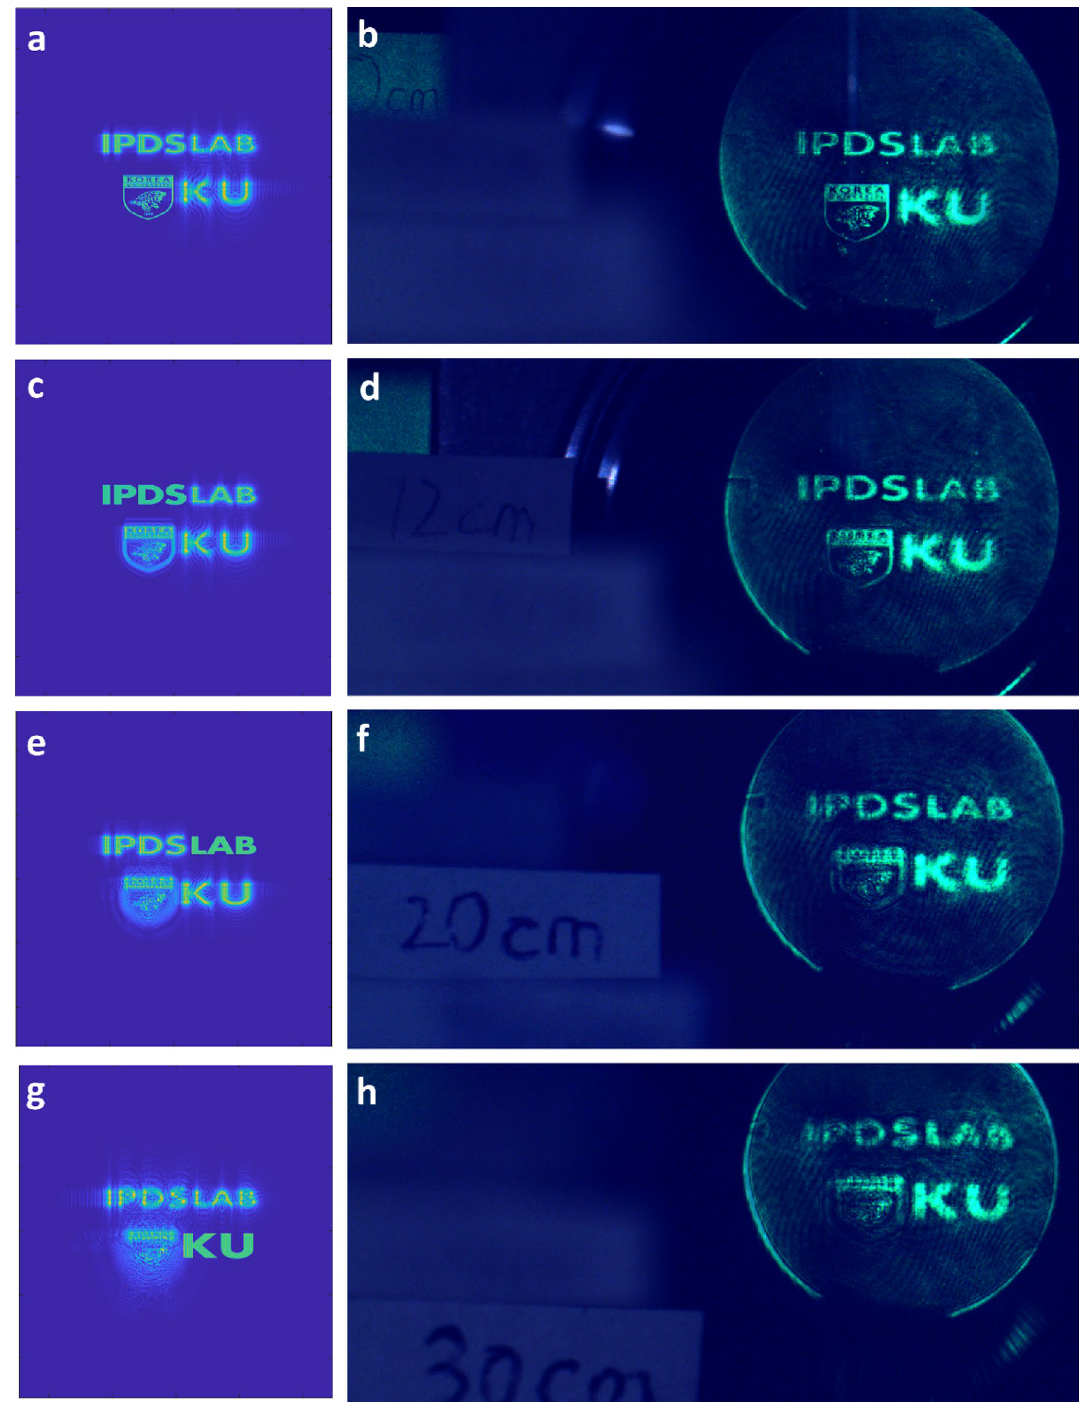
Figure 9. The simulated (left panel) and observed (right panel) holographic image of the designed complex CGH at the foci of 0 cm ( a , b ), 12 cm ( c , d ), 20 cm ( e , f ), and 30 cm ( g , h ). An additional video present dynamic operation of the device (Visualization